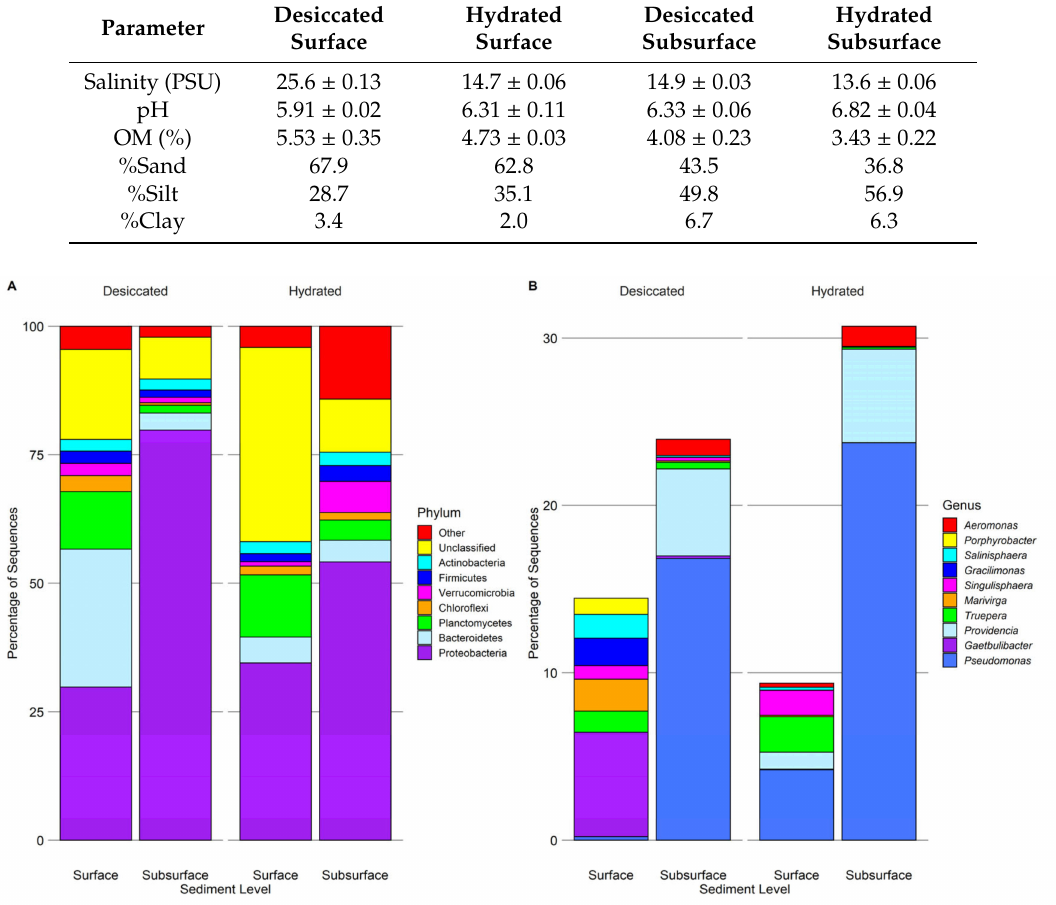
Figure 2. Representation of bacterial phyla ( A ) and genera ( B ) in saltpan wetland sediments collected from the Mississippi Gulf Coast and characterized by 16S rRNA gene sequencing. Major phyla ( A ) are shown as proportions of the total dataset of 96,391 bacterial sequences. Minor phyla are grouped as “other.” The ten most abundant overall genera ( B ) are shown as proportions of the total dataset. These ten represent 19.6% of the total sequences and ~82% of the sequences identified at the genus